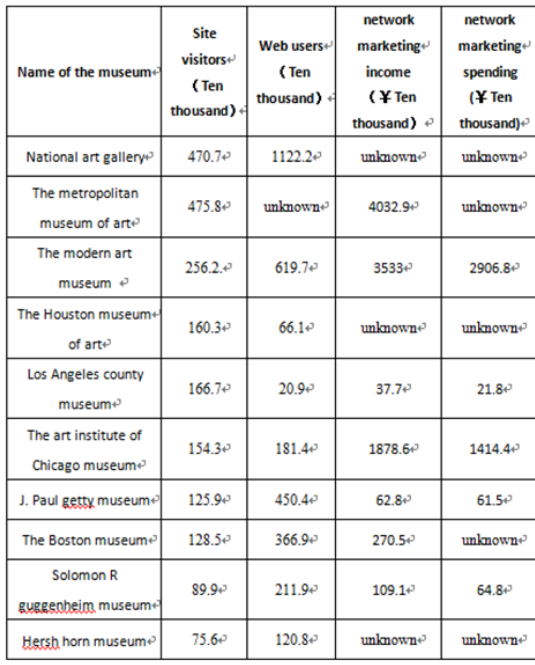
Table 1: Online vs. Site visits to the top 10 American museums in 2007